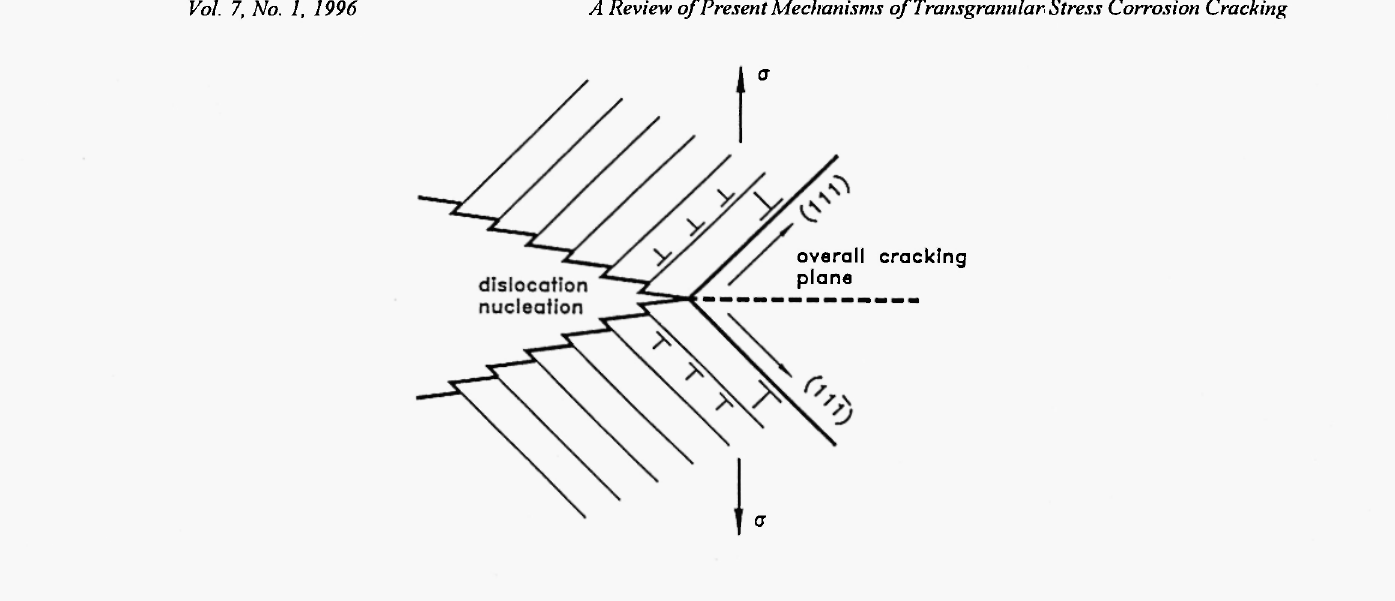
Fig. 12 Schematic illustration of proposed multiple dislocation nucleation and fracture surface characteristics produced during crack propagation